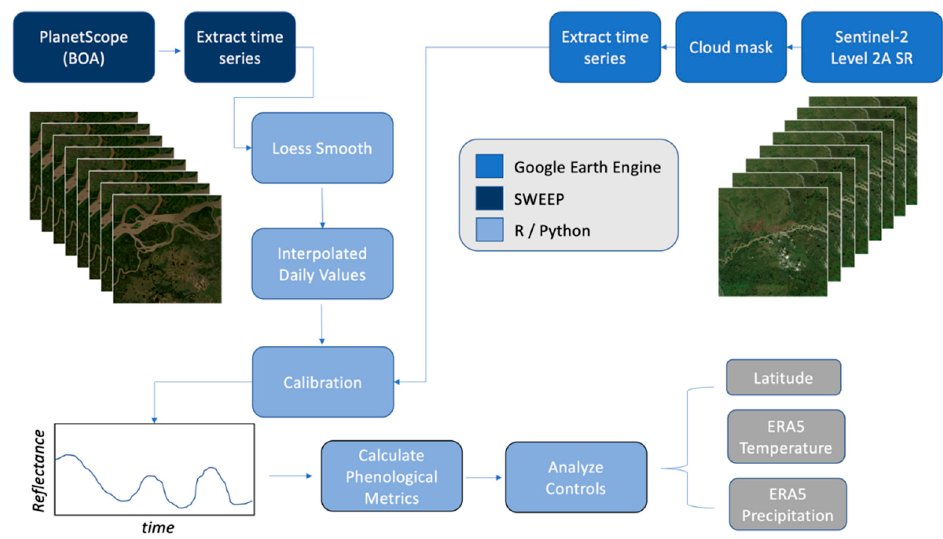
Figure 2. Workflow overview.